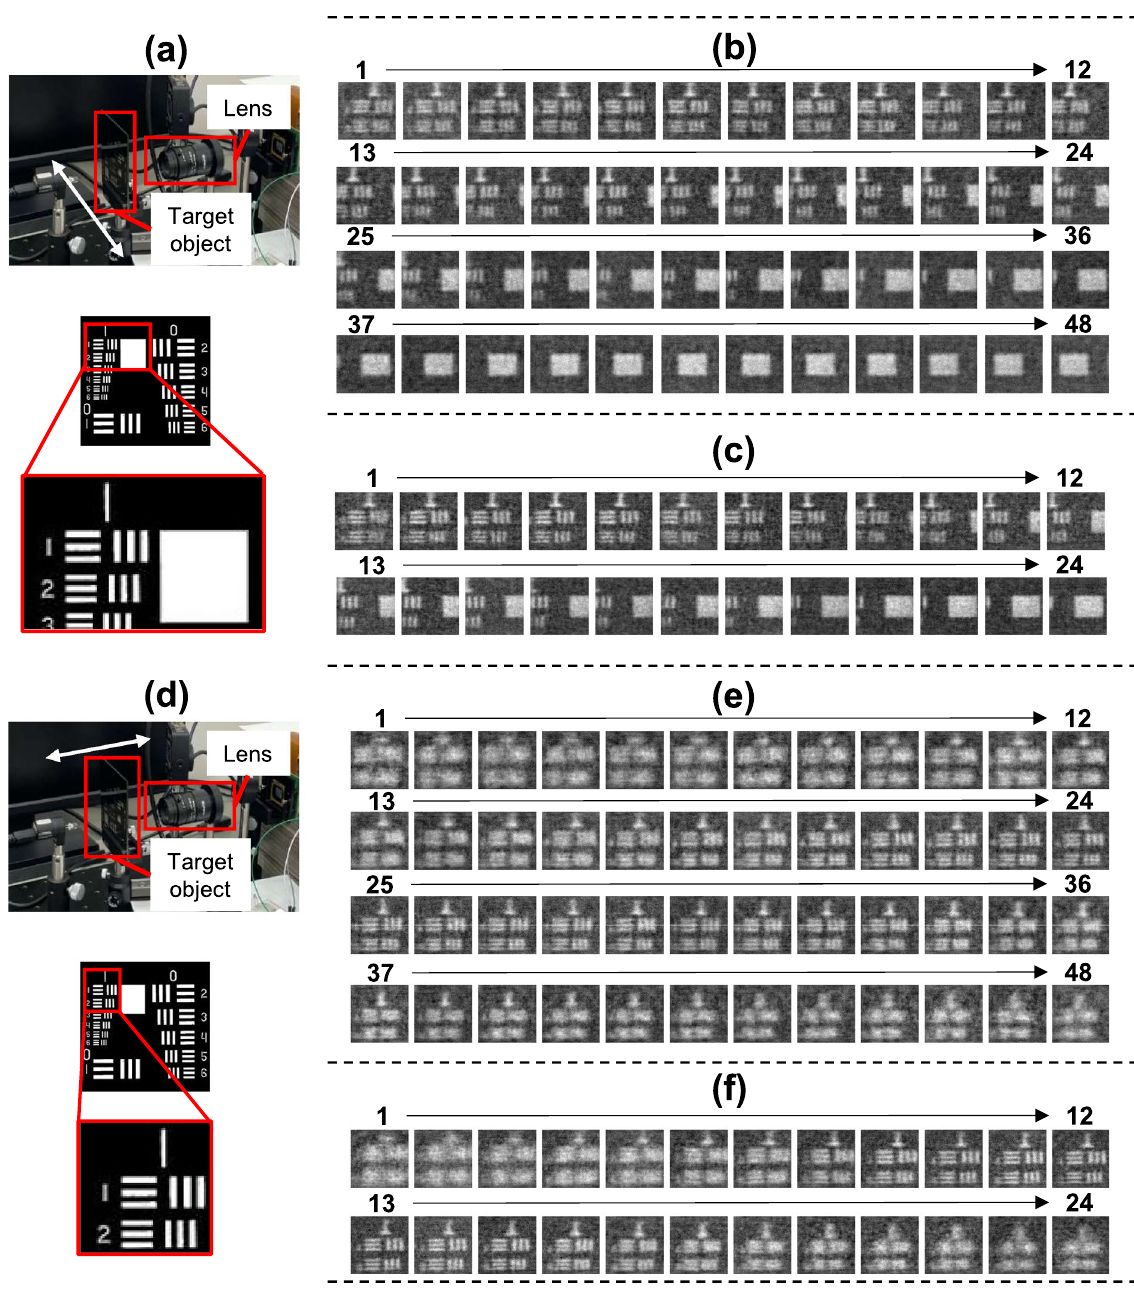
Figure 6. A reconstructed dynamic scene: ( a ) a target object (USAF1951 test target, Thorlabs R3L3S1N). The white arrow indicates the direction in which the target object is to be moved. The target object within the red rectangle moves in the direction of the arrow for 1 s, ( b ) reconstructed dynamic scene while moving the target object in the lateral direction in the case for 512 encoding mask patterns, ( c ) reconstructed dynamic scene while moving the target object in the lateral direction in the case for 1024 encoding mask patterns, ( d ) a target object when the movement direction is in the depth direction. The white arrow indicates the direction in which the target object is to be moved. The area indicated by the red rectangle was reconstructed. the target object was moved from − 1 cm to + 1 cm in 1 s, ( e ) reconstructed dynamic scene while moving the target object in the depth direction for 512 encoding mask patterns, ( f ) reconstructed dynamic scene while moving the target object in the depth direction for 1024 encoding mask patterns. The number of the reconstructed images is different since frames rate are different depending on the number of the encoding mask patterns, as shown in Table 2. The frame numbers are indicated above the